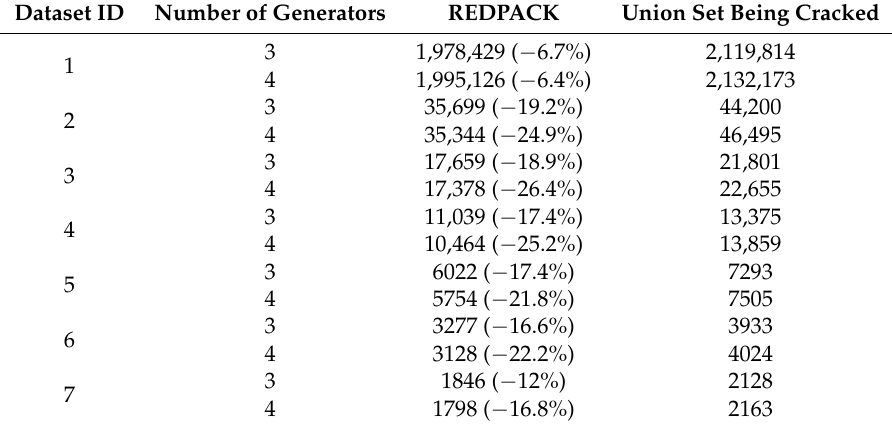
Table 4. Performance loss of REDPACK was compared with the union set of unit generator models’ cracking results. When there were three unit models, REDPACK consisted of PCFG, Hashcat (dive, rockyou-30000), when there were four it consisted of rPassGAN, and PCFG, OMEN, Hashcat and